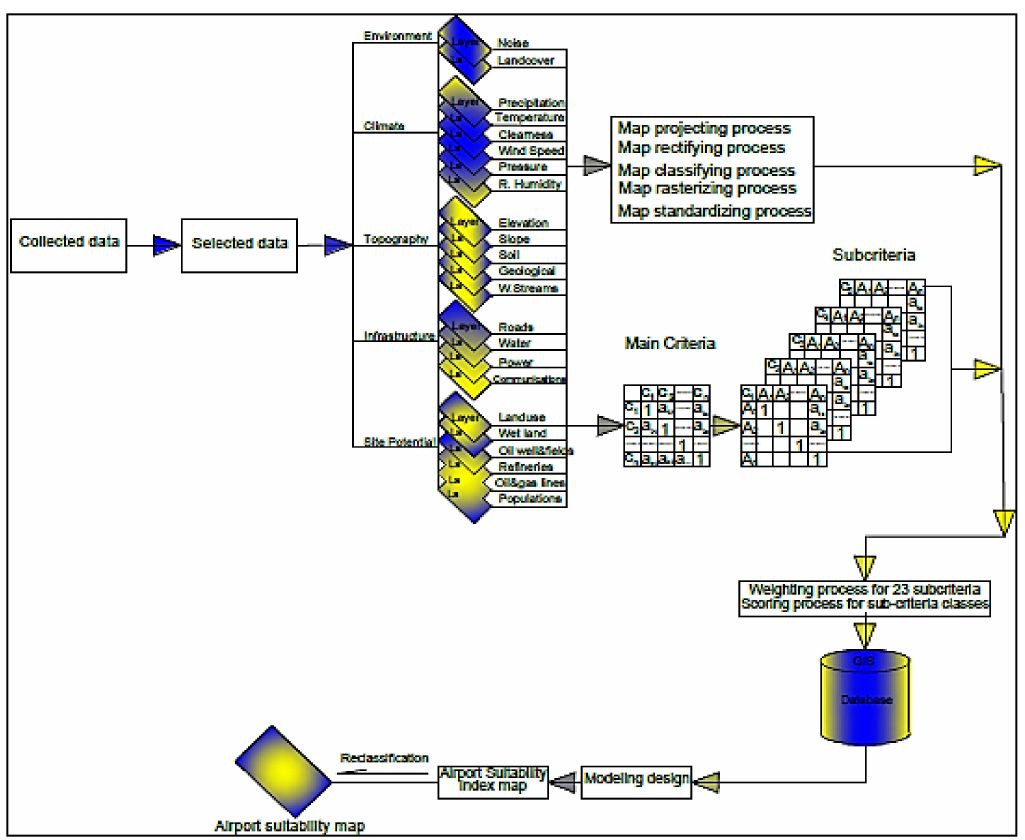
Figure 5. The flow chart of the methodology